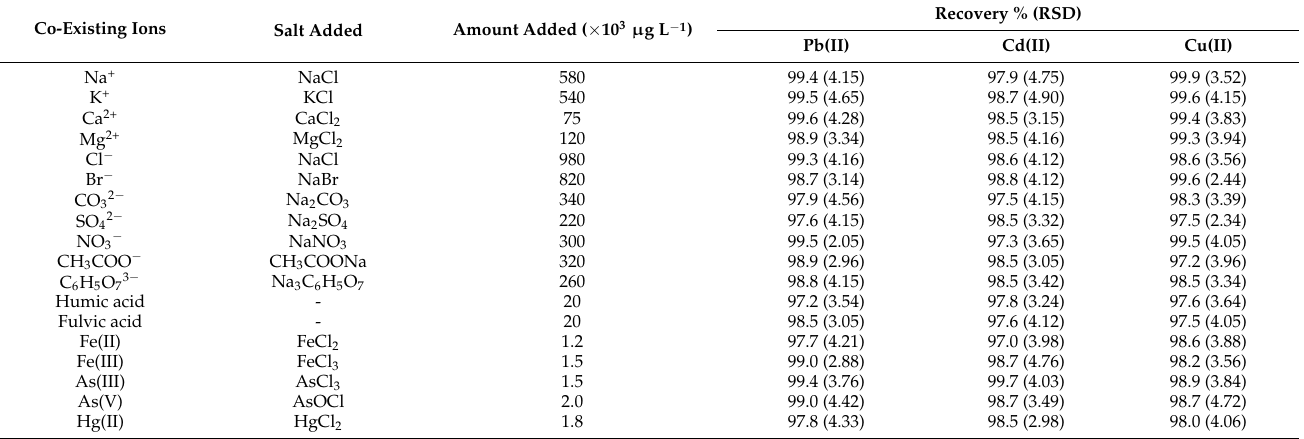
Table 1. Interference studies.